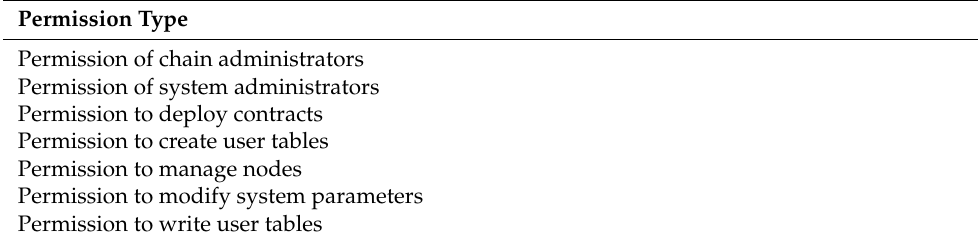
Table 3. Permissions related to the